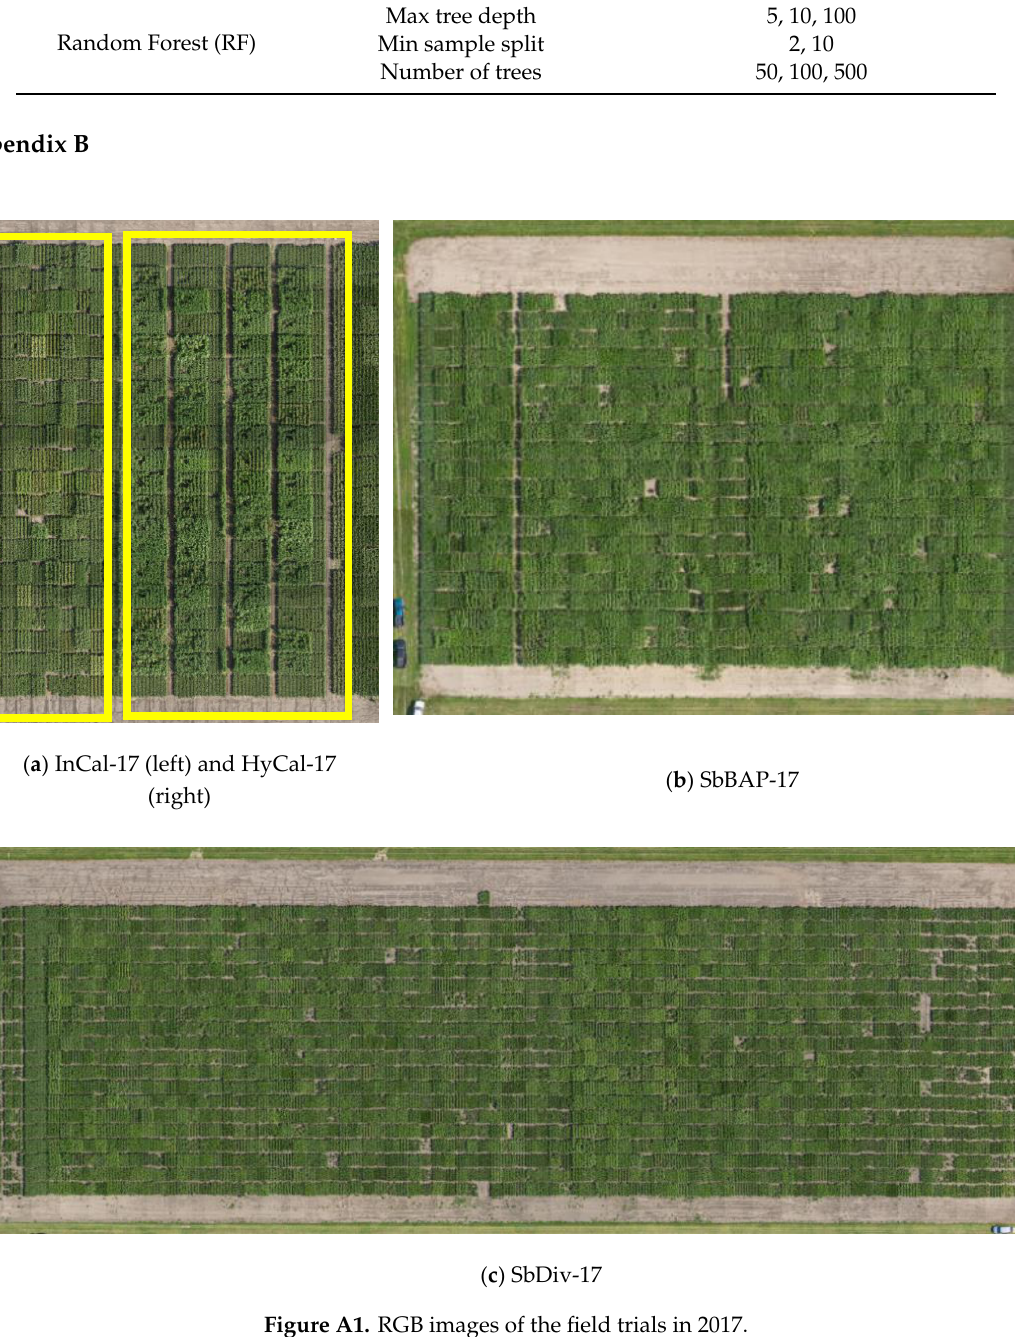
Figure A1. RGB images of the field trials in 2017.